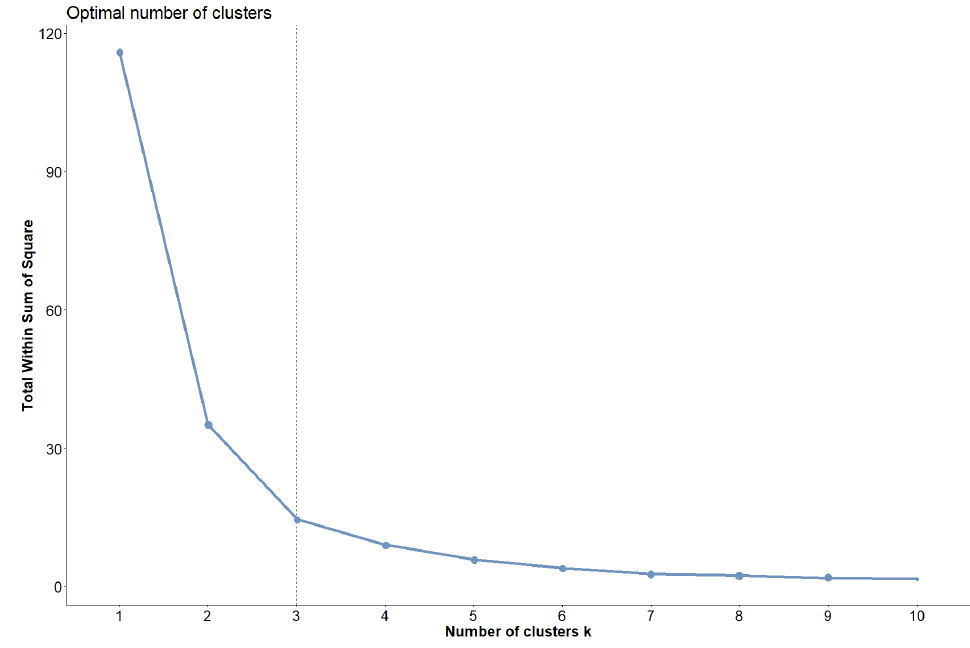
Figure 5: Identification of the optimal number of clusters using the elbow criterion for hierarchical clustering